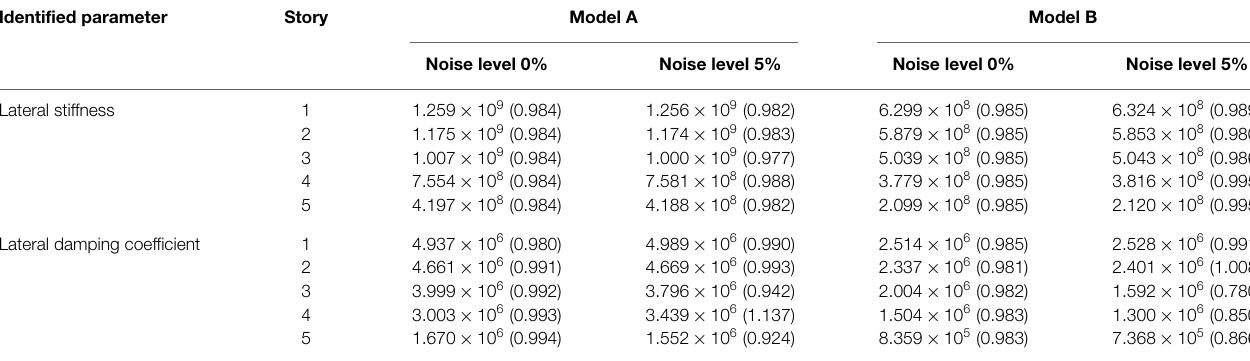
TABLE 2 | Identified value of lateral stiffness (N/m) and lateral damping coefficient (Ns/m) in each story (number in parenthesis: ratio to the true value). Identified